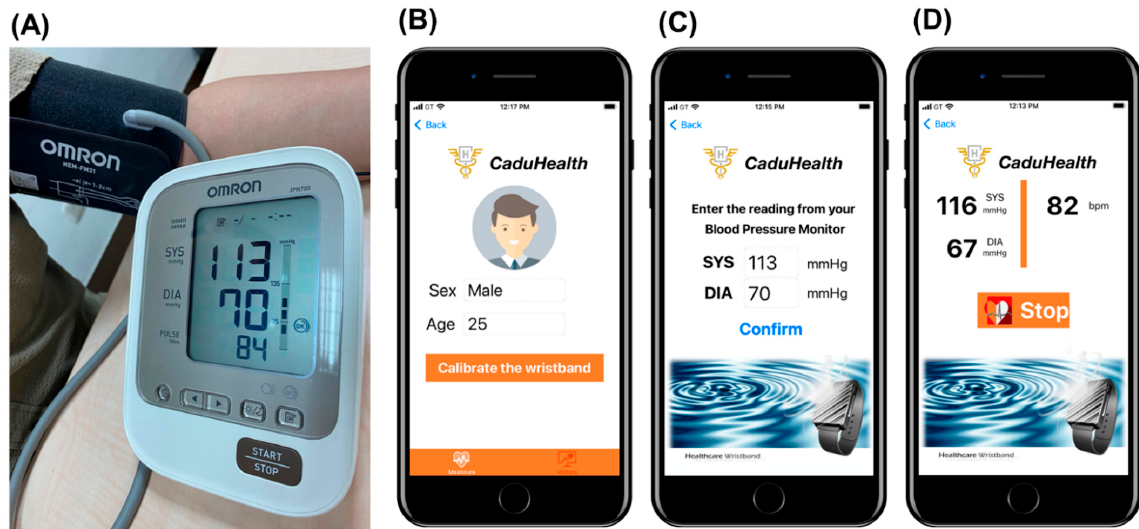
Figure 5. The details about proposed feedback calibration embedded in PPG devices. ( A ) The calibration system. ( B ) Step 1. Setting Up. ( C ) Step 2. Calibration. ( D ) Step 3. Measuring Blood Pressure.